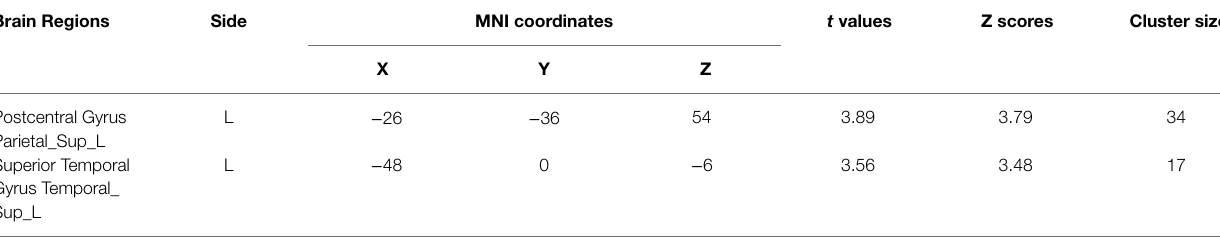
TABLE 2 | Activations associated with valence (Negative traits > positive traits). Brain Regions